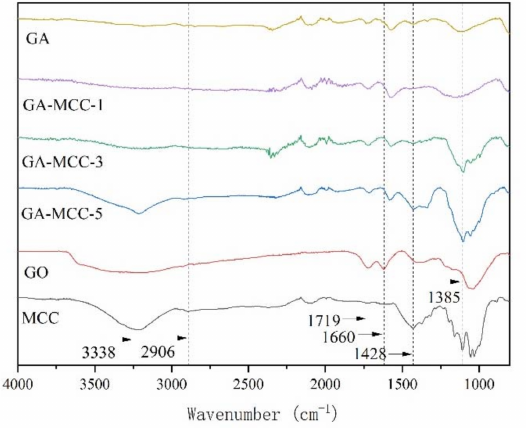
Figure 3. FTIR spectra of GA aerogel, GA-MCC-1 aerogel, GA-MCC-3 aerogel, GA-MCC-5 aerogel, GO and